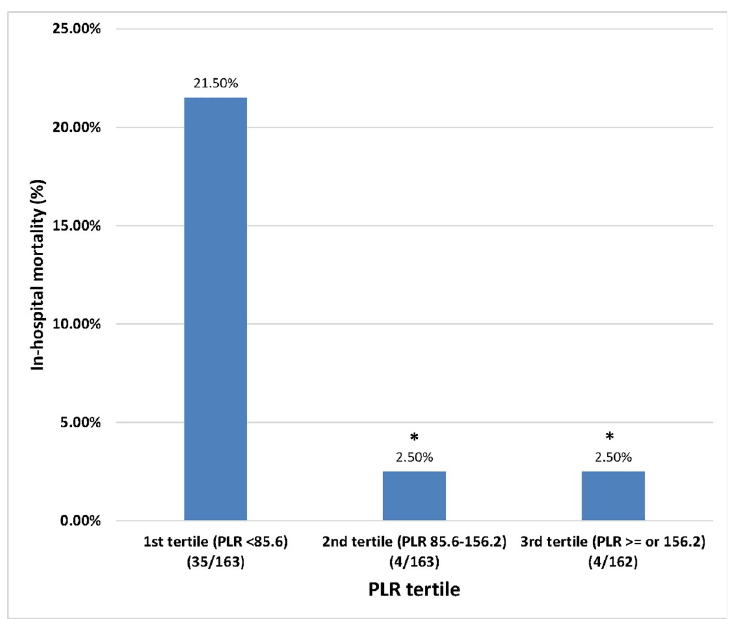
Fig 2. In-hospital mortality according to tertile of platelet-to-lymphocyte ratio (PLR).